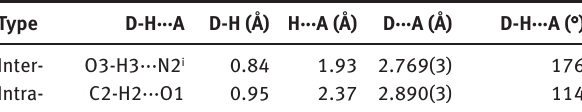
Table 3: H-bonding geometry parameters (Å and ° ) for the